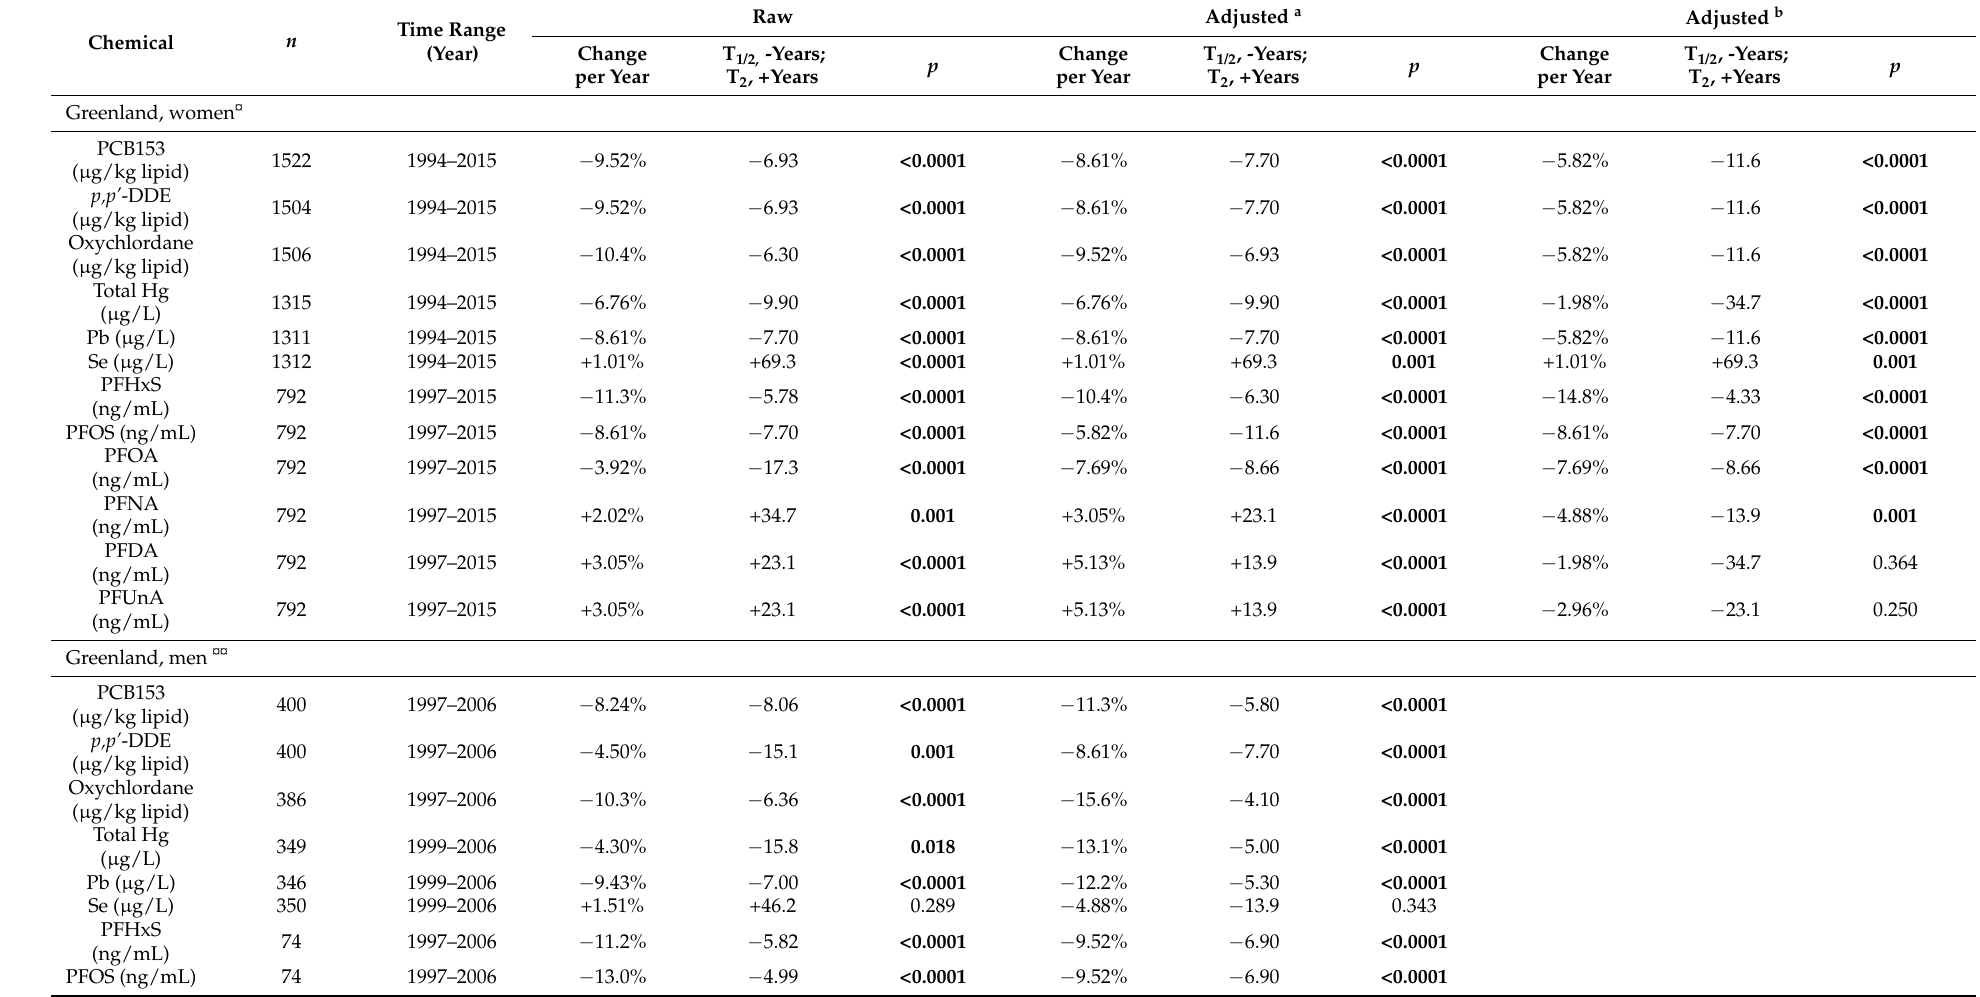
Table 8. Women and men across Greenlandic: changes in the levels of lipPOPs, metals and PFASs, given as the time to halve the concentration (T 1/2 ) or the time to double the concentration (T 2 ).